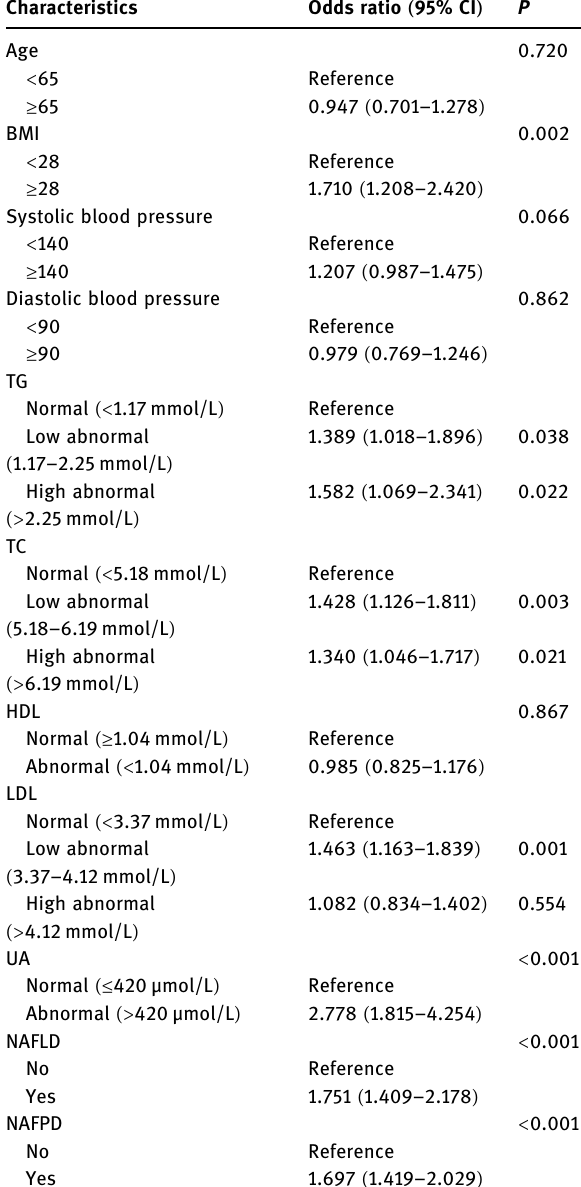
Table 3: Multivariate analysis of factors associated with breast cancer